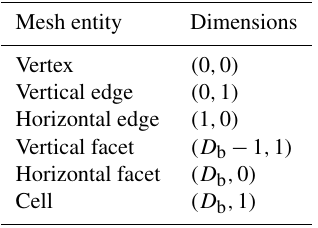
Figure 2. Mesh entities used in the extrusion process to connect entities in Fig. 1 (left to right): vertical edges, vertical facets, three- dimensional cells.